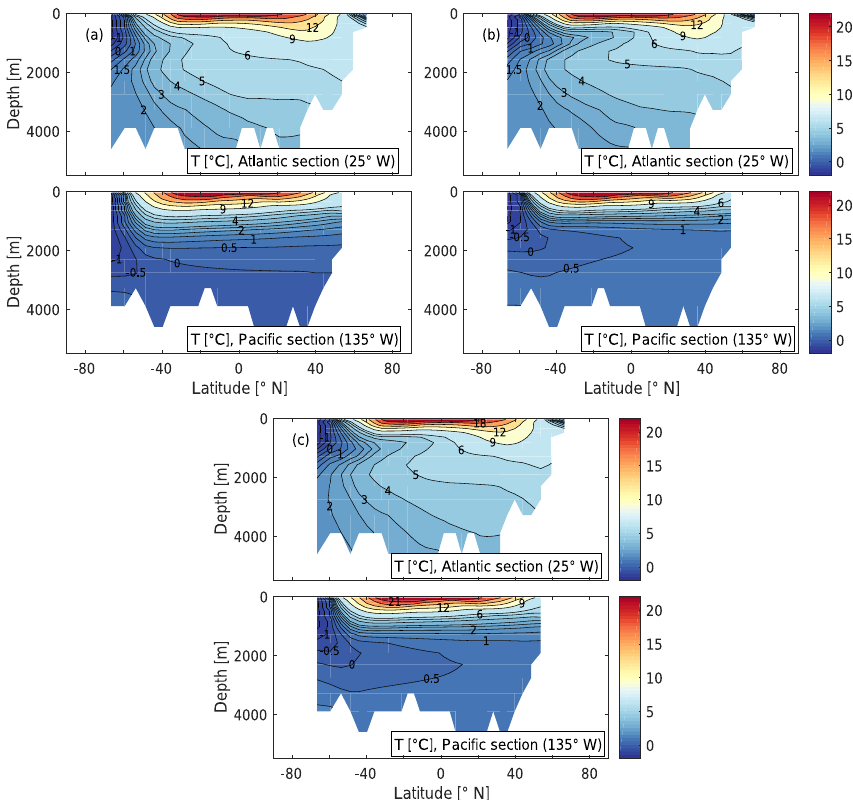
Figure 7. Sections of temperature ( ◦ C) for (a) DD × 2, with high diapycnal diffusivity, (b) DD / 2, with low diapycnal diffusivity, and (c) the control PIES278. The upper panel of each subfigure shows a section through the Atlantic at 25 ◦ W and the lower panel shows a section through the Pacific at 135 ◦ W. Both sections also cover latitudes that are in the Southern Ocean (south of − 30 ◦ N).